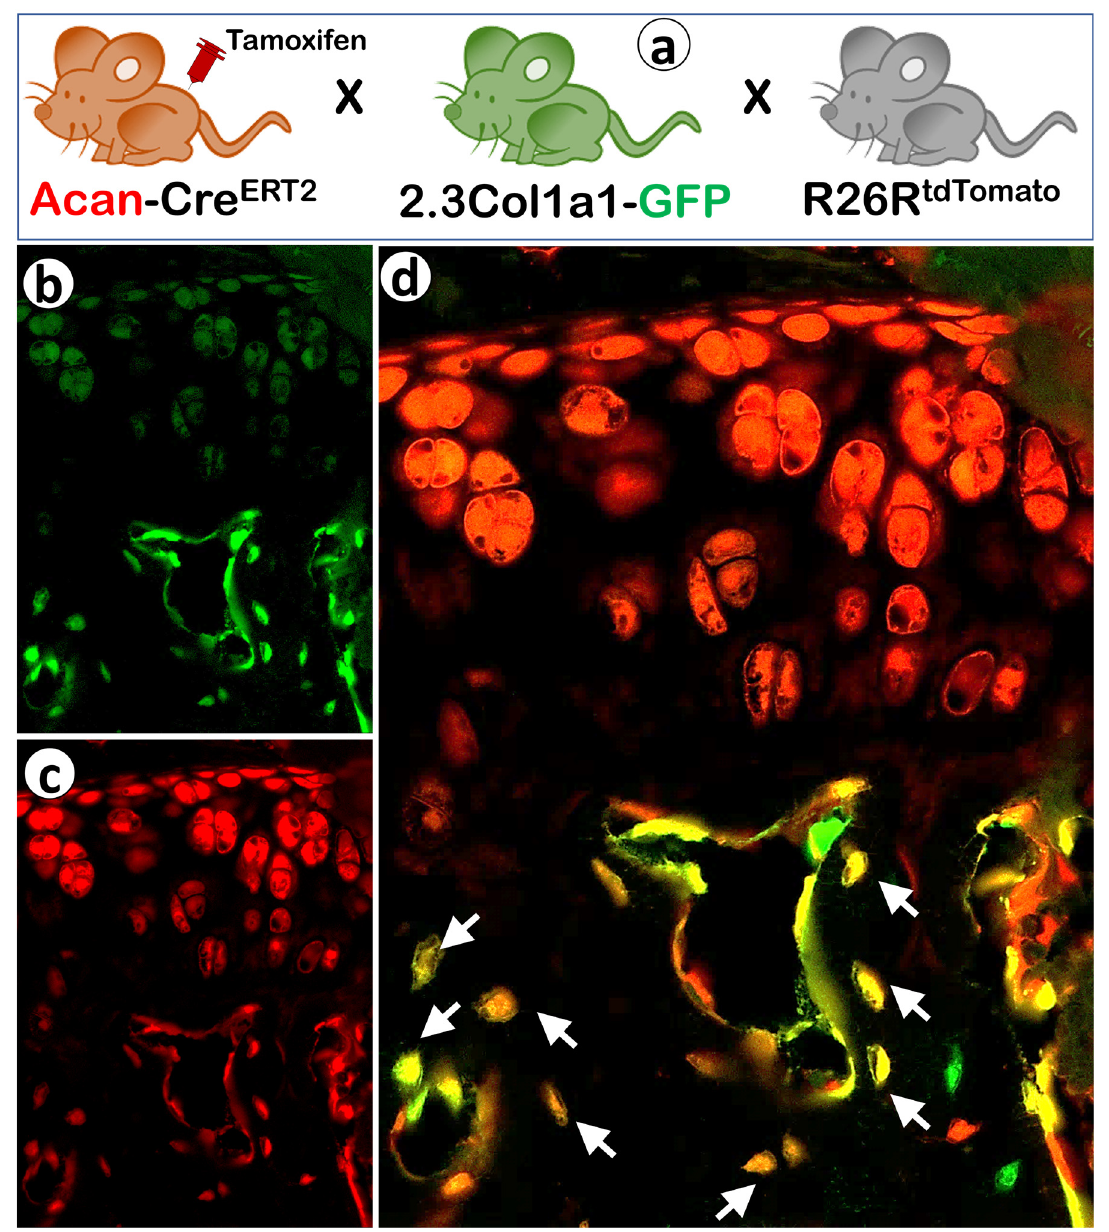
Figure 2. Cellular co-localization of the chondrocyte-derived tomato marker and a 2.3 Col1a1-GFP osteoblast-specific marker in the TMJ condyle cartilage and underlying trabecular bone. ( a ) The schematic diagram illustrates the generation of triple mice containing Acan-Cre ERT2 , 2.3Col1a1-GFP, and R26R tdTomato along with a tamoxifen induction to activate the Cre event. ( d ) Confocal images of the GFP ( b ) and Tomato ( c ) signals in the articular cartilage of a 6-week-old mouse. ( c ) The merged image of GFP and Tomato signals, which revealed non-chondrocyte-derived bone cells (green), chondrocyte-derived bone cells with no GFP activation yet (red), and chondrocyte-derived bone cells expressing type I collagen (yellow as denoted with